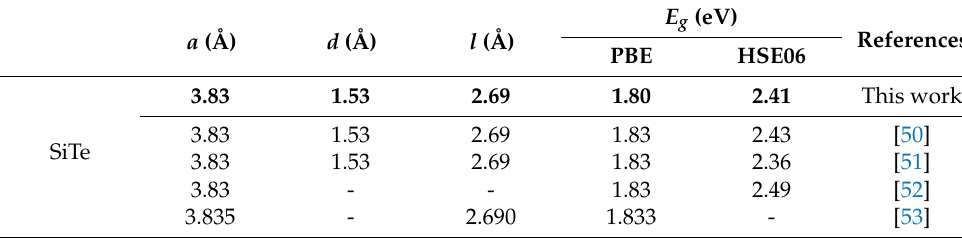
Figure 1. ( a ) Top view, ( b ) side view, ( c ) phonon dispersions, and ( d ) the total energy fluctuations during AIMD simulations of 2D polar monolayer SiTe. Table 1. Comparison of the calculated values of lattice constant ( a ), vertical layer distance ( d ), bond distance ( l ), and band gap ( E g ).